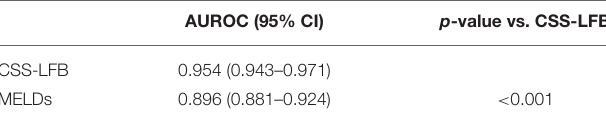
TABLE 3 | Comparison of the performance to grade the severity at the peak disease by Chinese scoring system and MELD scoring